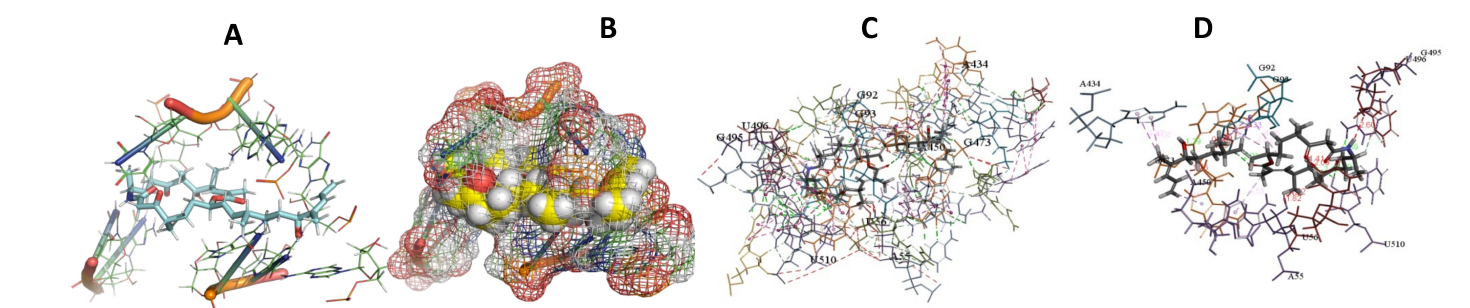
Figure 8. T. cruzi + Angiolam ( A ): Best binding pose and nucleotides involved. ( B ): Schematic binding pocket. ( C ): shows the Nucleotides component that re involved in binding. ( D ): Shows the main bonds involved between the compound and the nucleotide component.